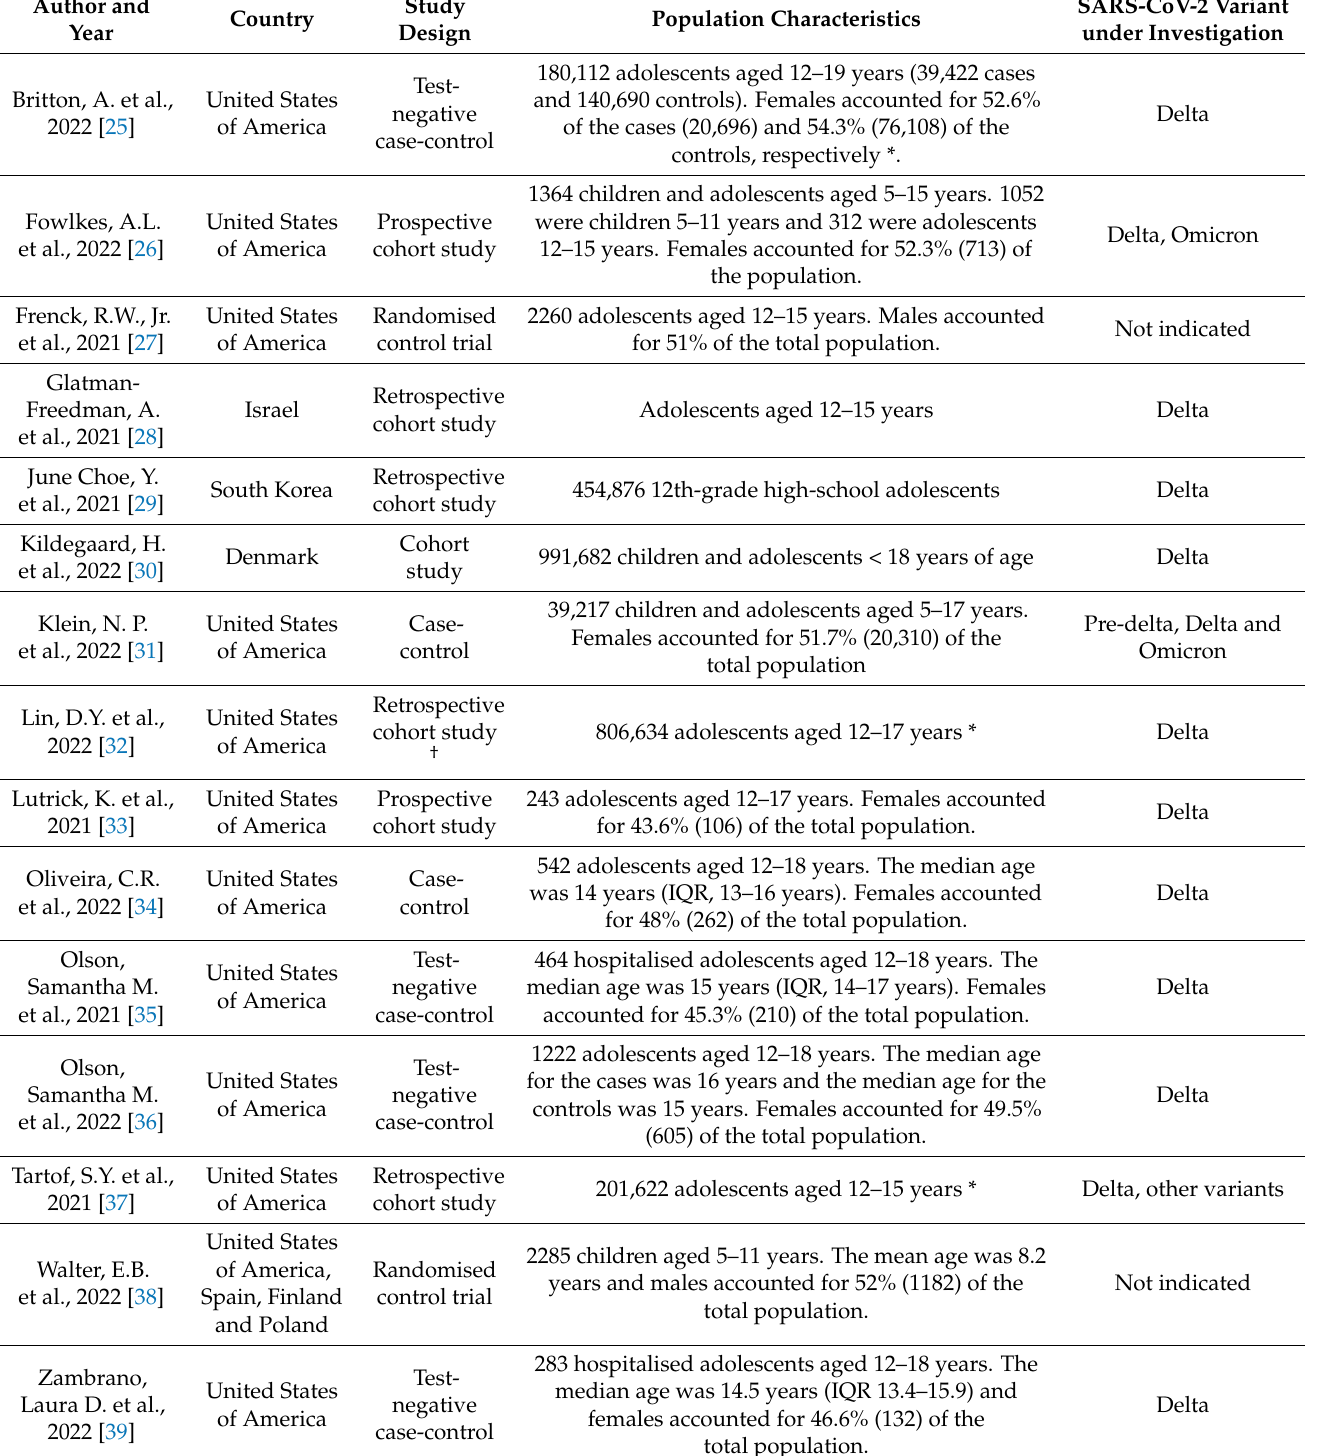
Table 1. Characteristics of the Included